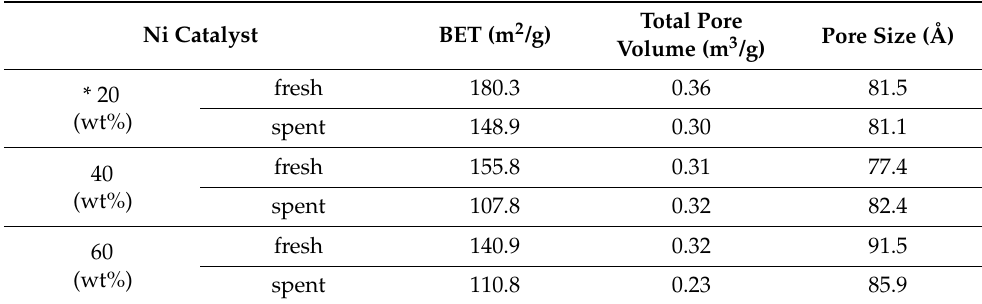
Table 2. BET specific surface area, pore volume, and pore size of Ni-Mg-Al catalysts containing different proportions of Ni before (fresh) and after (spent) experiments.